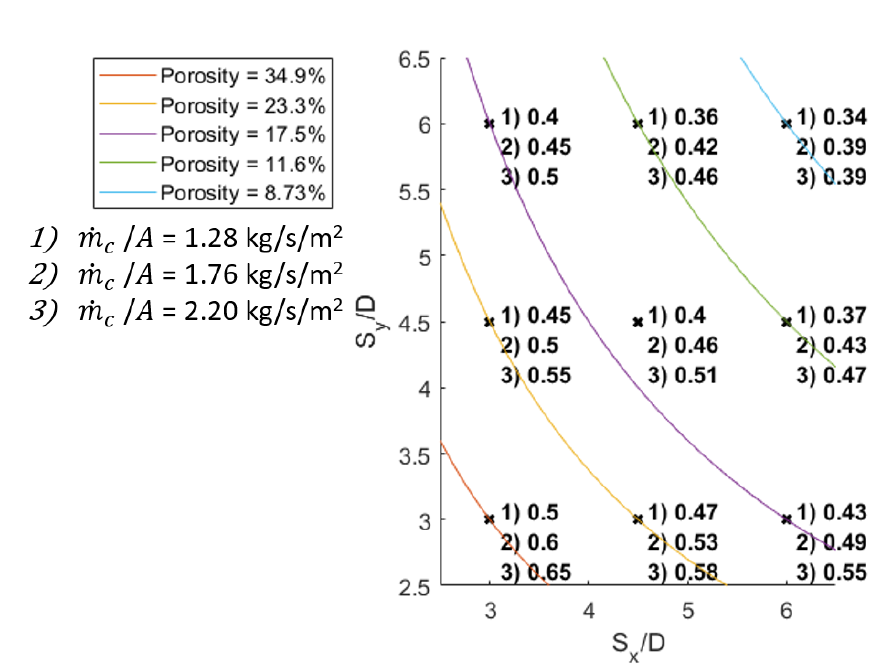
Figure 7. The effect of film spacing ( S x , S y ) on area-averaged film effectiveness, for three coolant mass flows. Isobars of constant porosity are